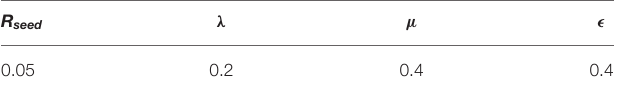
TABLE 1 | Value of the hyperparameters of VCCS used for the experiments in the present paper. R